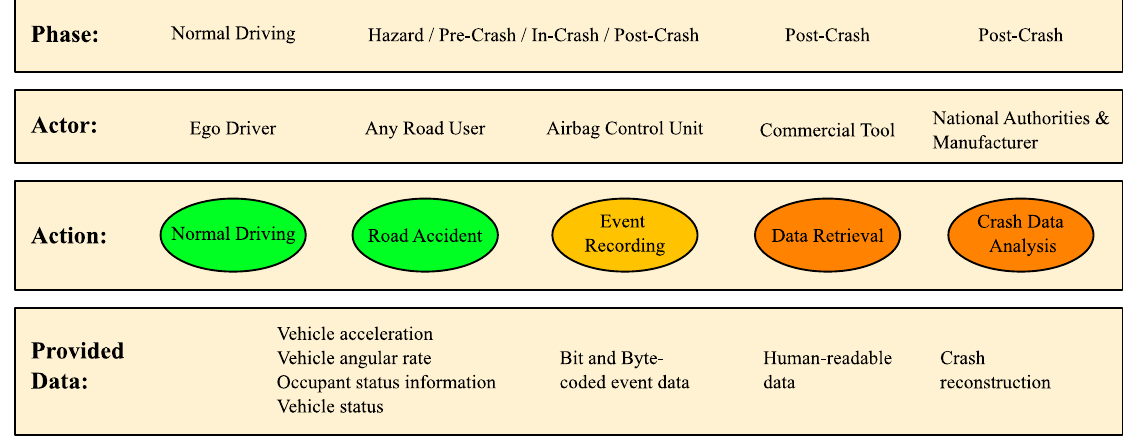
entry (yellow) and the testability in terms of combinatorics. Referring to the data ele ‐ ments, various properties are defined like which states of a buckle switch have to be recorded or the range and resolution of an acceleration signal. For the event entries, the handling of the recording is described—trigger conditions, data recording and rules when to overwrite or discard events. Additionally, it contains the information of the processing status and, taking all available EDR entries into consideration, a crash ‐ history can be determined (because of the existing rules how to record, overwrite or discard events). For testing, the combinatorics per data element is limited due to the limited range of available inputs and data properties. In contrast to this, the combinatorics of recording event entries can be judged as unlimited. This is because the event entries are reflecting the crash ‐ history data and there are unlimited scenarios possible when it comes to reflect real ‐ world crash scenarios. 2.1. Handling of Event Data Recorder (EDR) Event Entries Focusing on the recording of an EDR event entry, the main items to be considered are: 